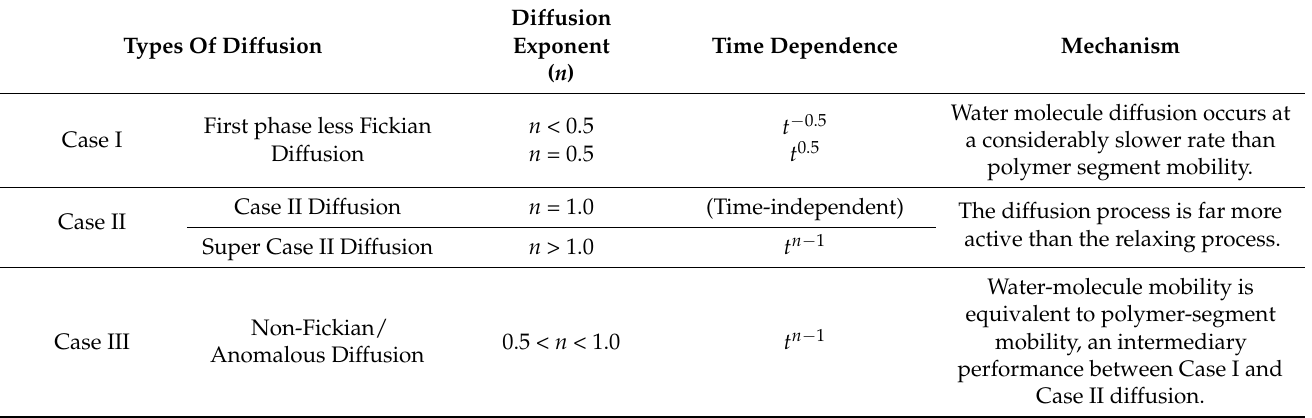
Table 4. Water ingress mechanism of pure and modified sisal composites